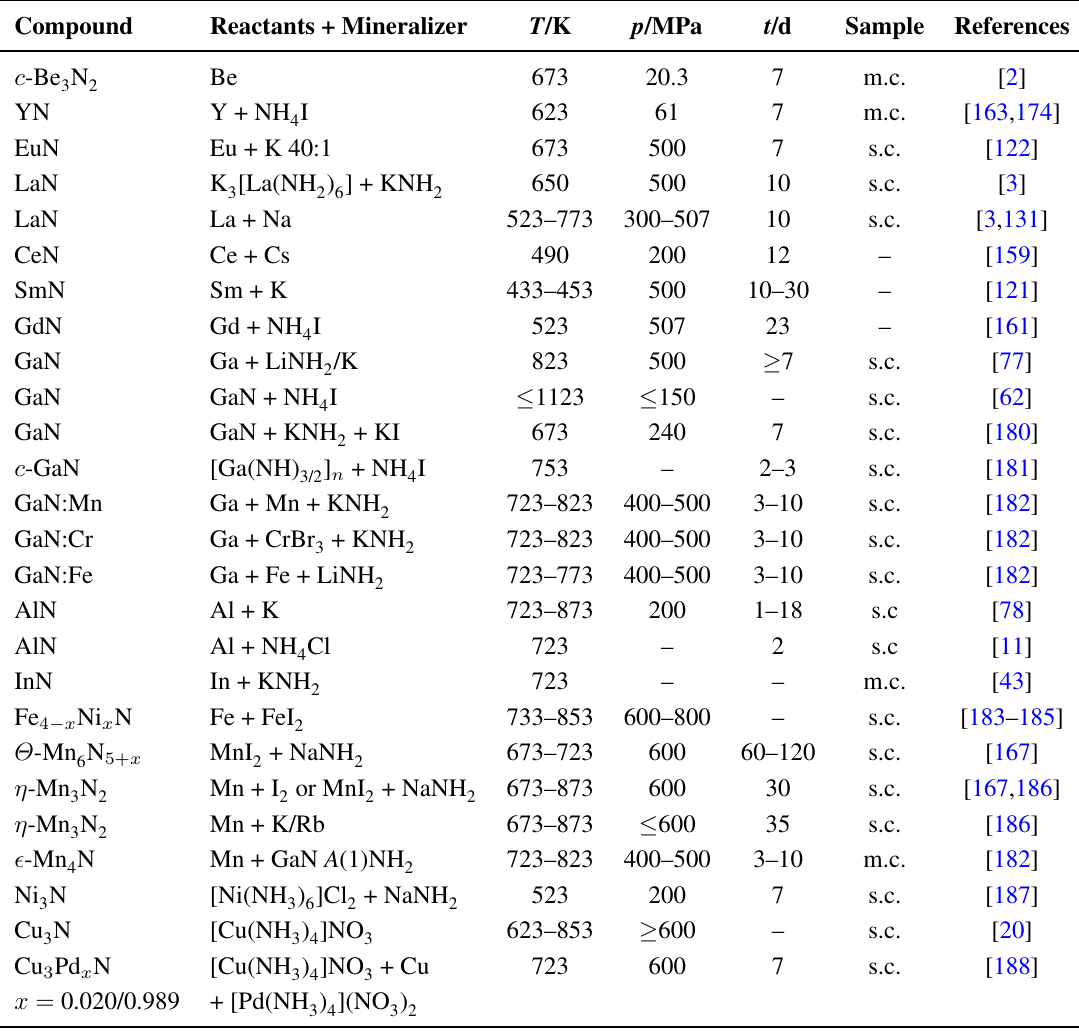
Table 10. Conditions for the ammonothermal synthesis of binary